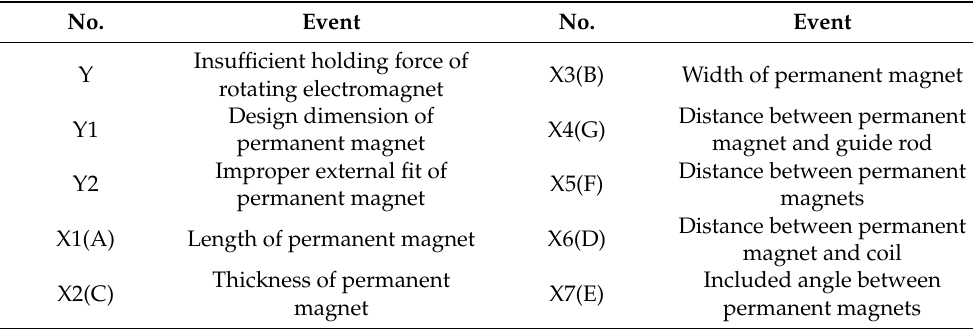
Figure 5. Fault tree of insufficient holding force of rotating electromagnet. The intermediate events and basic events represented by the symbols in the electro- magnet fault tree in Figure 5 are shown in Table 1. Table 1. Meaning of symbols in fault tree of rotating electromagnet.